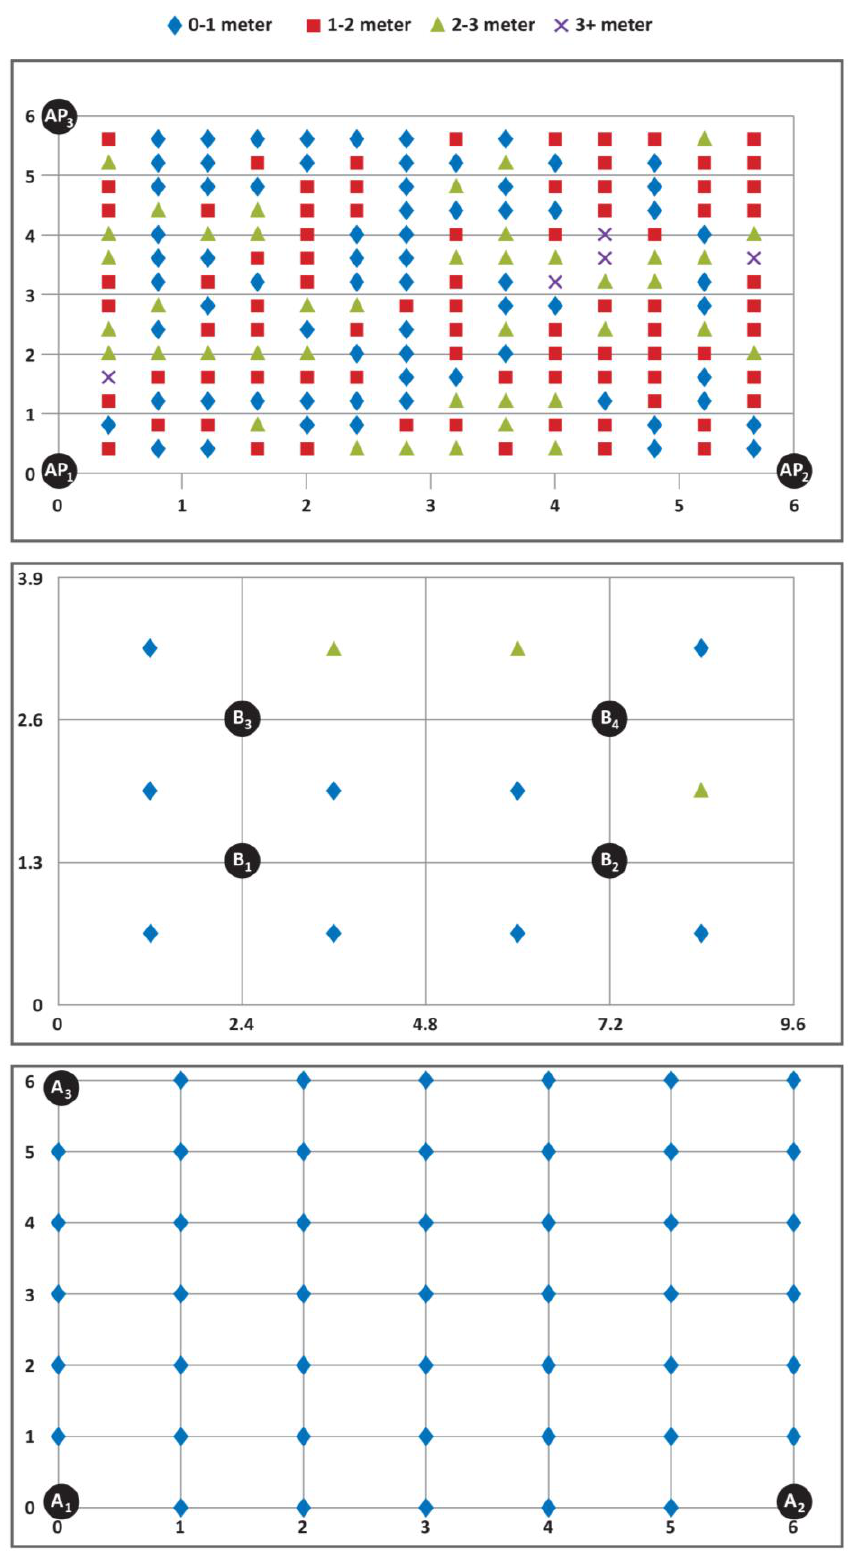
Figure 2. Reference points’ accuracy errors for Wi-Fi, BLE beacon and UWB (from top to bottom). AP x : wireless access points; B x : BLE beacons; A x : UWB anchors.